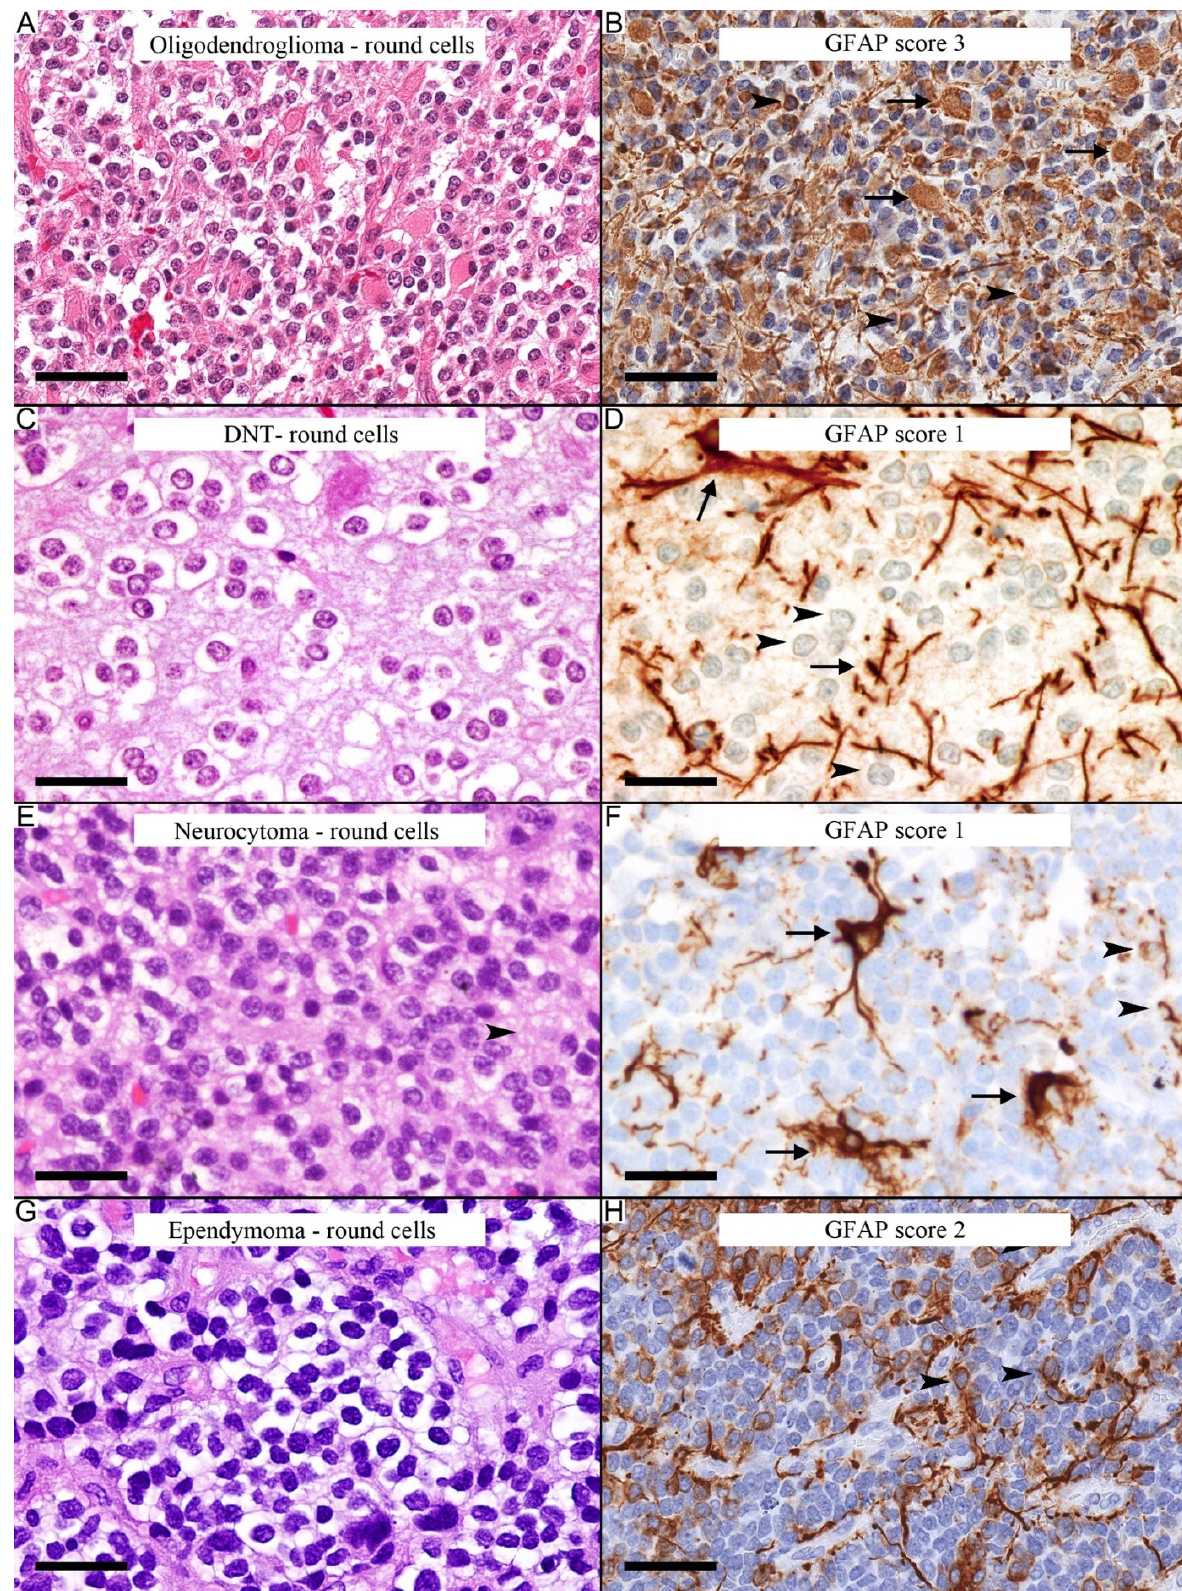
Figure 3. GFAP staining in oligodendrocyte-like areas in other tumors. ( A ) Oligodendroglioma with an area rich in neoplastic gliofibrillary oligodendrocytes and minigemistocytes. ( B ) GFAP highlights